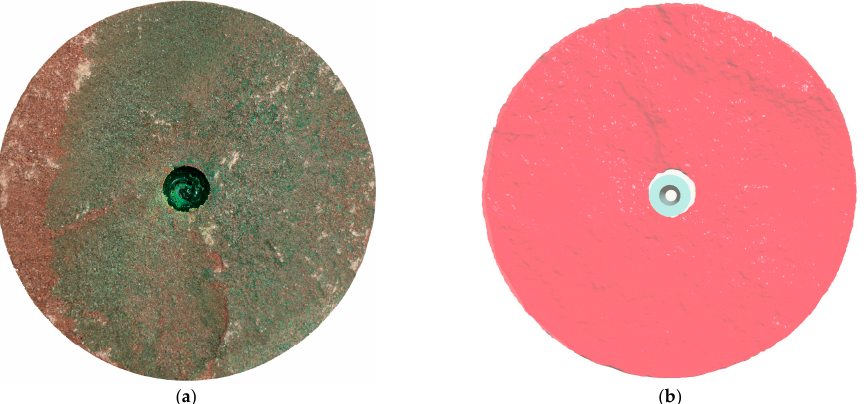
Figure 12. Hydraulic fracture morphology of sample S4: ( a ) Post-fractured view, ( b ) scanning reconstruction view. The post-fractured view and the scanning reconstruction diagram of the hydraulic fracture morphology of all samples in cyclic hydraulic fracturing are shown in Figure 13. When the upper limit of the cyclic pump pressure was 90%P b , sample S5 formed an obvi- ous longitudinal main fracture after the 32nd cycle under the condition of “high-pressure duration 15 s + low-pressure duration 5 s”. Because the injection rate was greater than the fluid loss, the main fracture could pass through the bedding plane and continue to expand in the direction of axial stress; thus the oblique downward extension activated a horizontal bedding plane. On the scan reconstruction diagram of hydraulic fracture morphology, an approximate “L”-shaped fracture appeared, forming a relatively complex fracture. Under the condition of “high-pressure duration 10 s + low-pressure duration 10 s”, after the end of the 25th cycle, part of a horizontal bedding surface was activated in sample S6, forming a long horizontal bedding joint. On the scanning reconstruction diagram of the hydraulic fracture morphology, there is approximately a horizontal “1” type fracture, which formed a fracture with greater undulation than in sample S4. Under the condition of “5 s for high- pressure duration + 15 s for low-pressure duration”, sample S7-1 formed a transverse frac- ture zone after the 7th cycle and activated a horizontal bedding plane. On the hydraulic